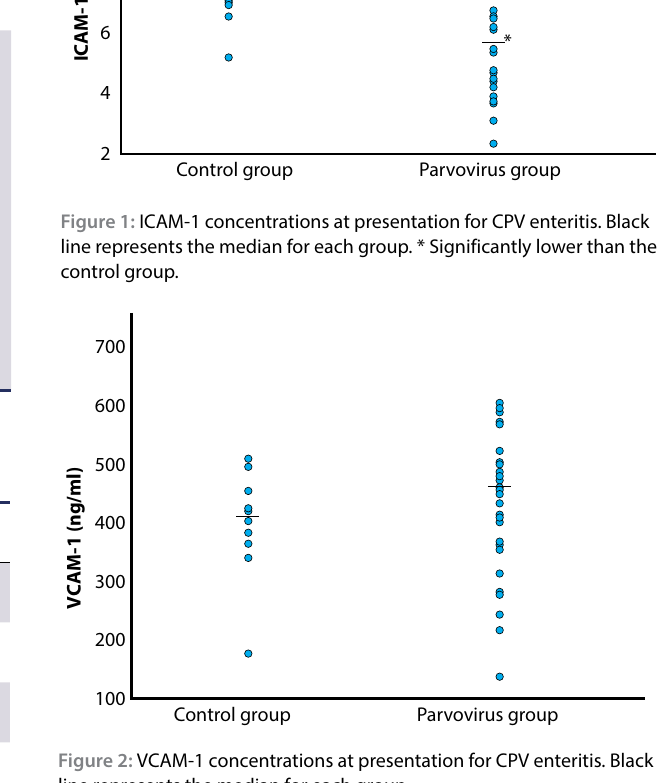
Figure 2: VCAM-1 concentrations at presentation for CPV enteritis. Black line represents the median for each group.